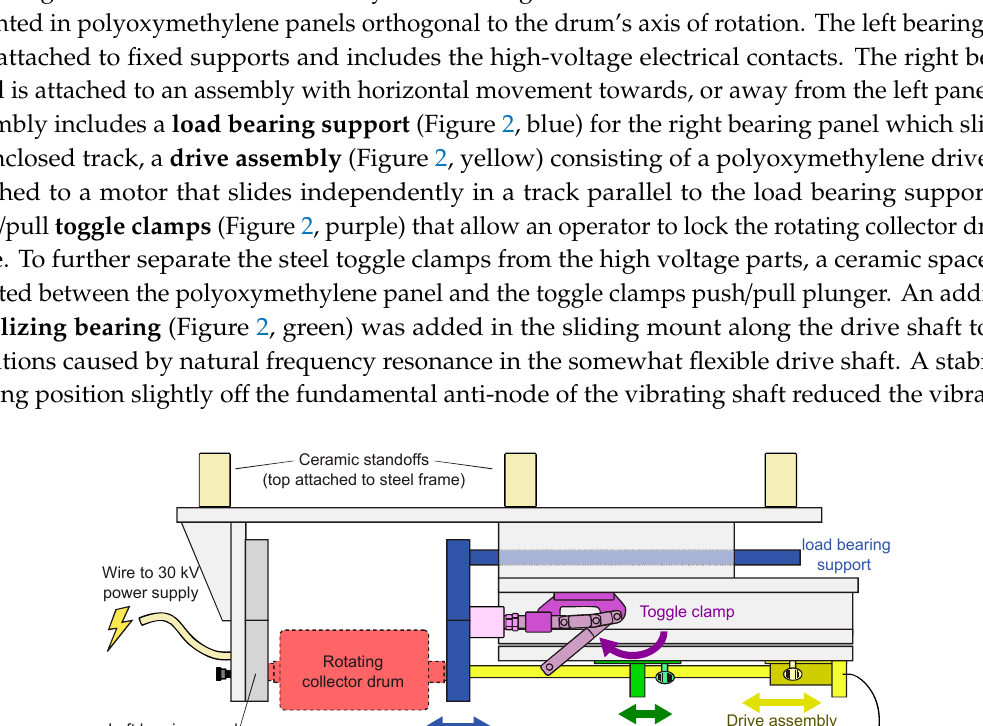
Figure 3. A diagram of the high voltage contact to the high-speed rotating collector drum. The high- voltage supply wire is soldered to a copper support which makes contact with the spring-loaded non- rotating pointed copper rod and the outer races of the bearing. The non-rotating pointed copper rod makes contact to the center of the collector drum’s axel.